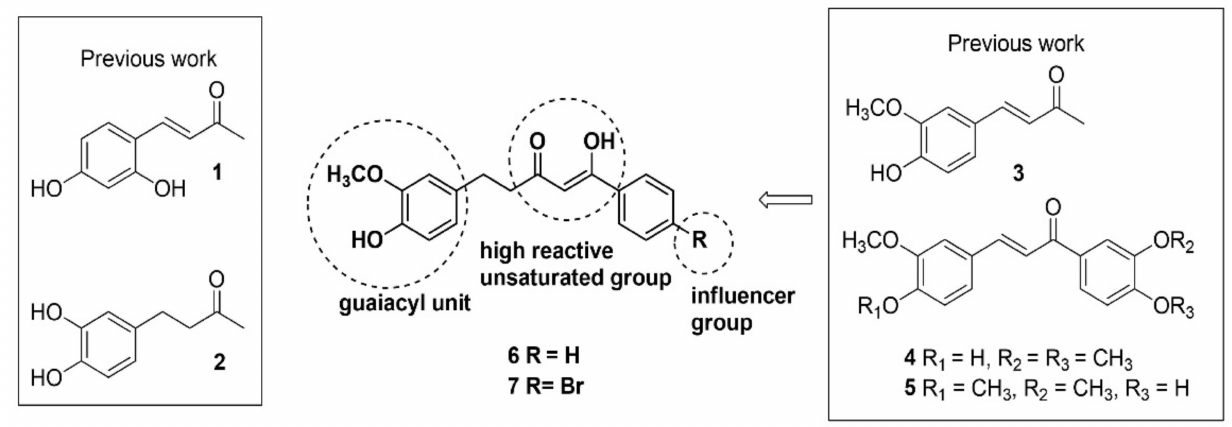
Figure 3. Design of tyrosinase inhibitors 6 and 7 based on the chemical structure of inhibitors 3 – 5